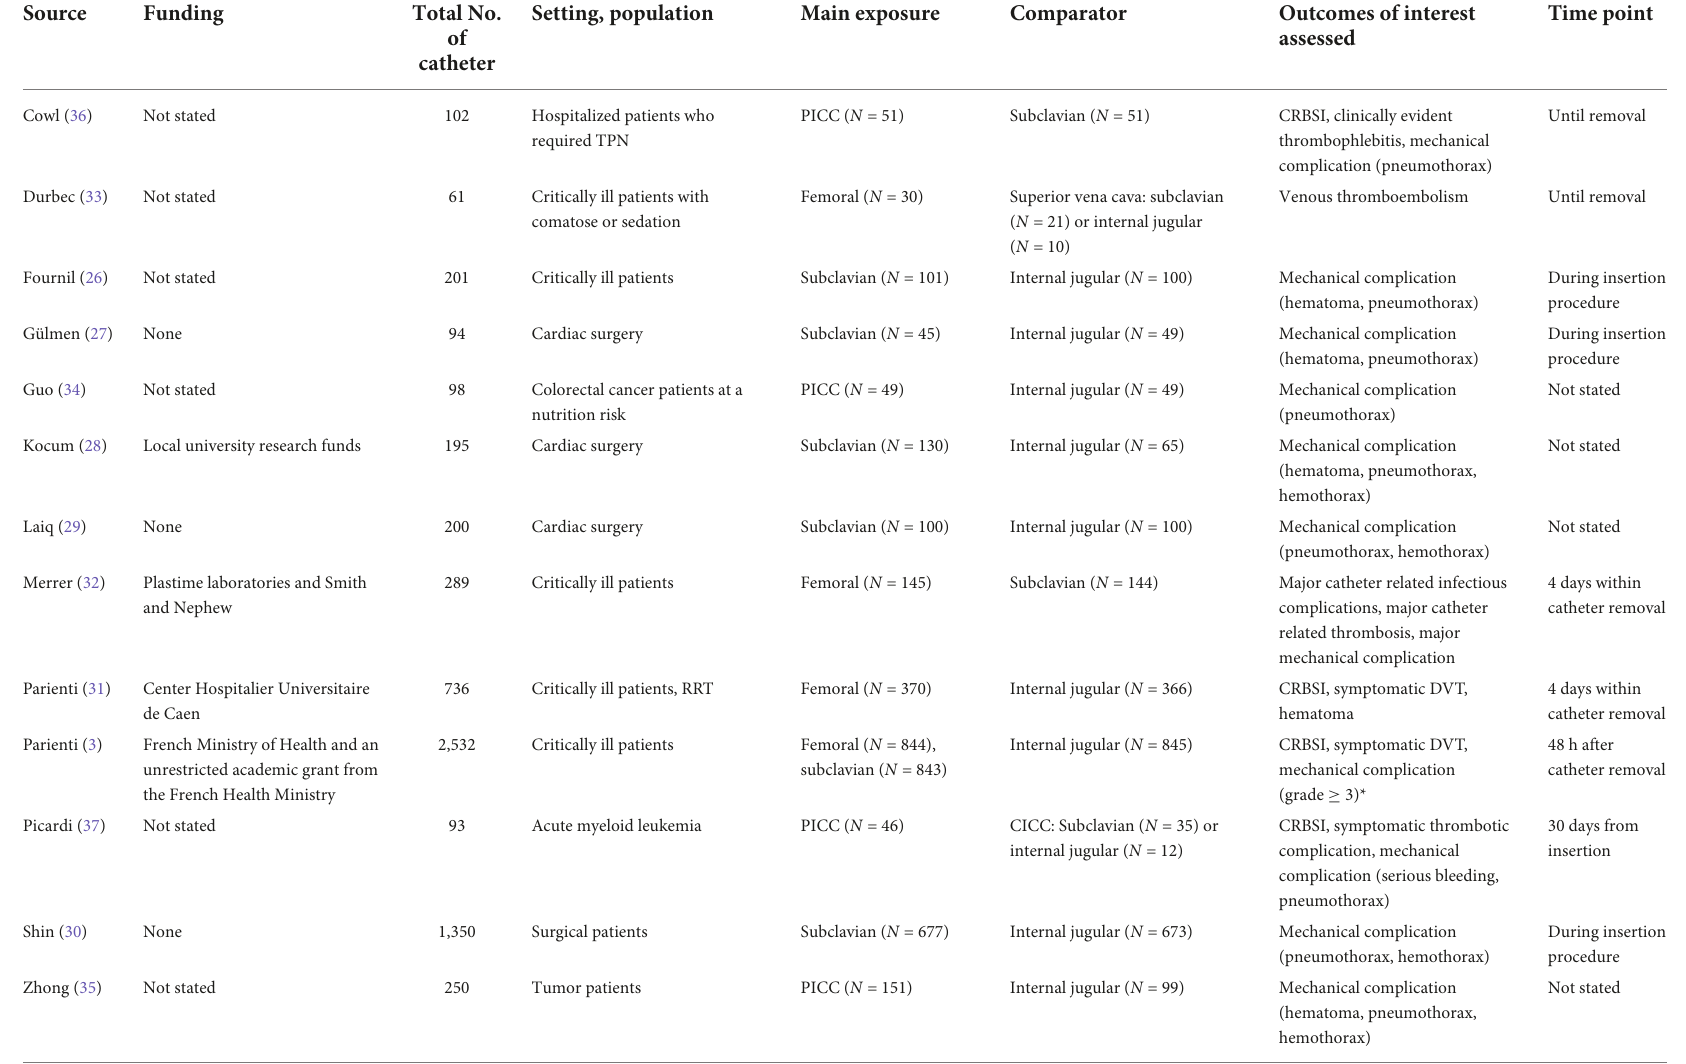
TABLE 1 Summary of characteristics of the studies included in the network